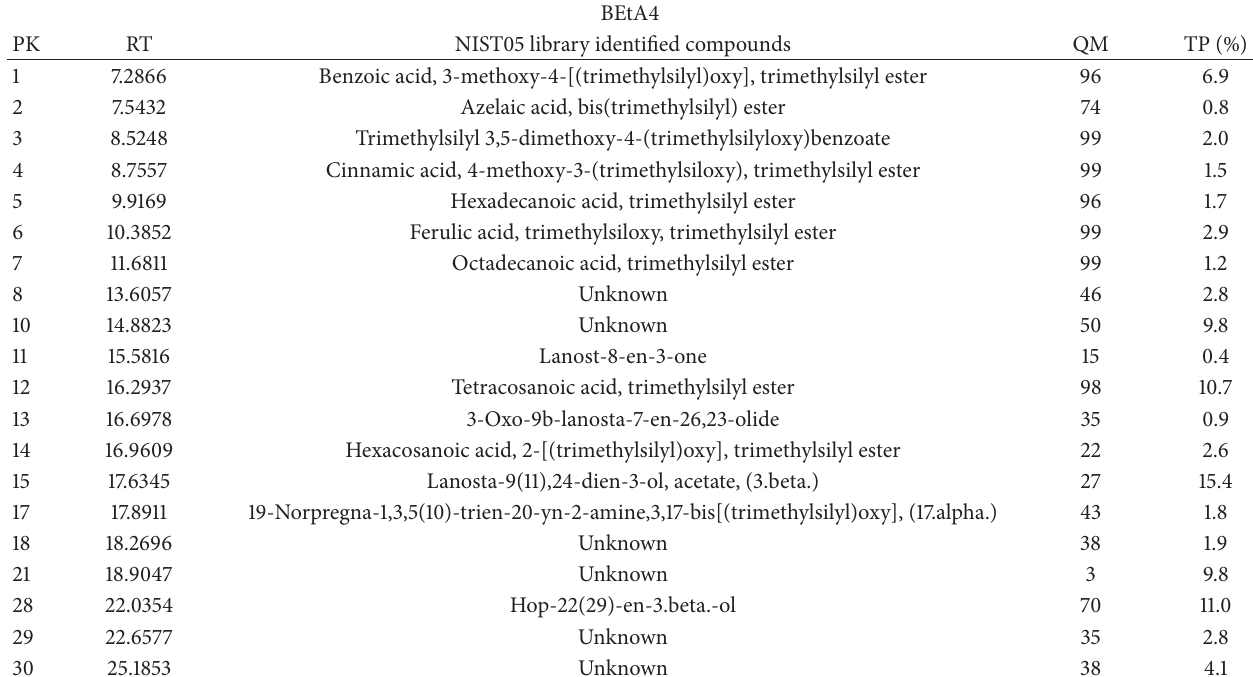
Table 6: Identified compounds (twenty) from the BEtA4 fraction and their total percentage present.